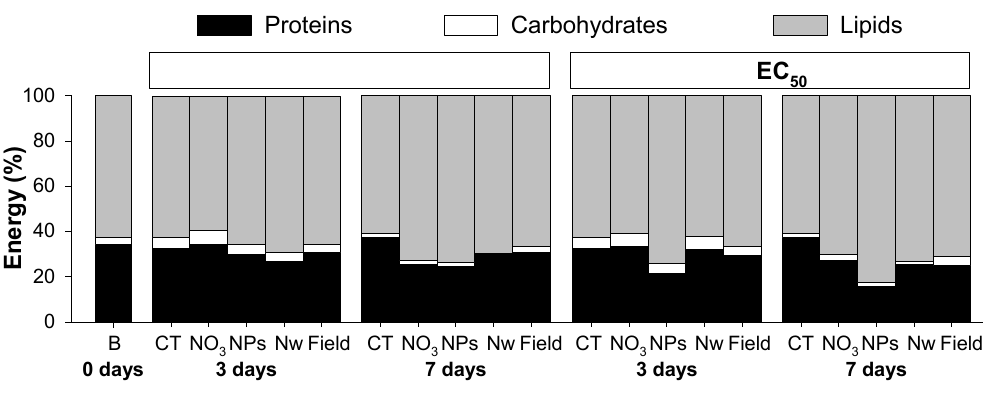
Figure 1. Proportion of energy reserves available (proteins, carbohydrates and lipids) in Enchytraeus crypticus after exposure to the concentrations of effect on reproduction EC 20 and EC 50 of copper nitrate (NO 3 ), copper nanoparticles (NPs), copper nano-wires (Nw) and copper-salt from field contamination (Field), for 0, 3 and 7 days. CT: control, B: Baseline (organisms from